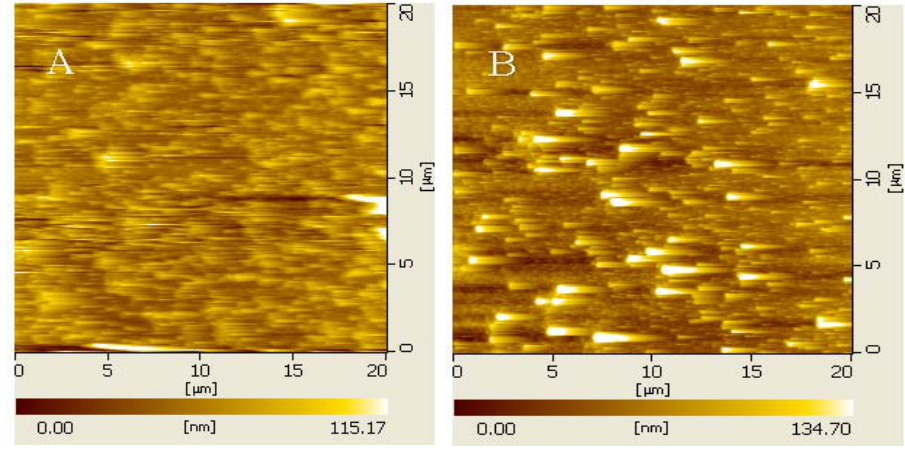
Figure 4. AFM images of silicon chip substrate modified with IMA at concentration of 25 µg/L ( A ) and IMA–AuNP complex of 25 µg/L ( B